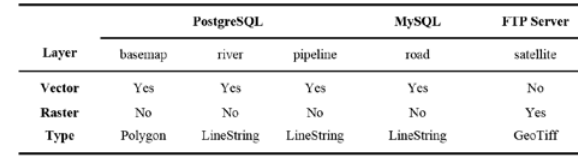
Table 1. List of layers from multiple data